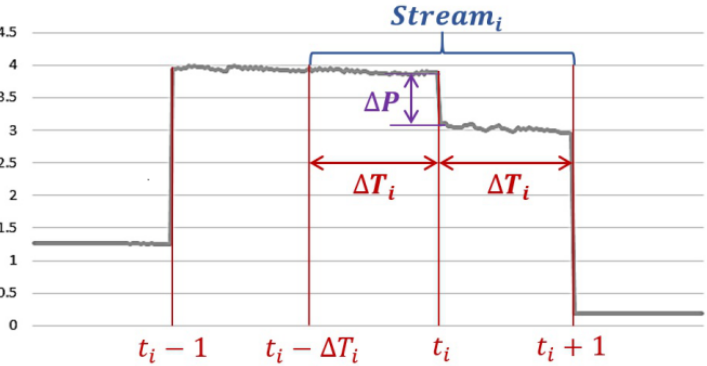
Figure 6. Example of data-stream extraction for a single feature. The stream is acquired from an interval with length of 2∙∆T_i.